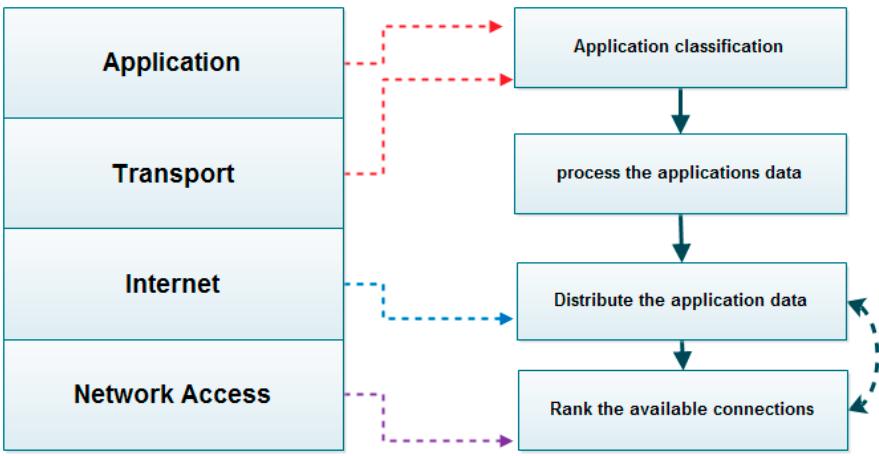
Figure 5. Relationship between the proposed system model and the TCP / IP model.